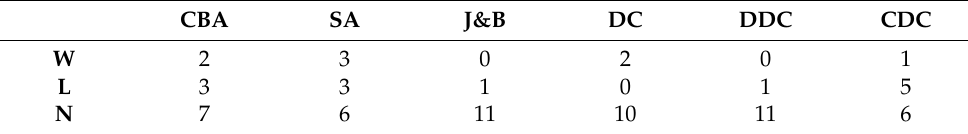
Table 5. Statistically significant wins/losses counts of CCC3 method on